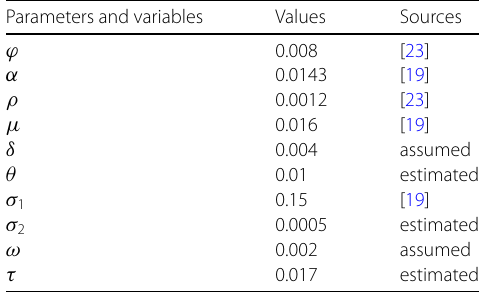
Table 3 Values of parameters, state variables, and their sources for numerical simulation Parameters and